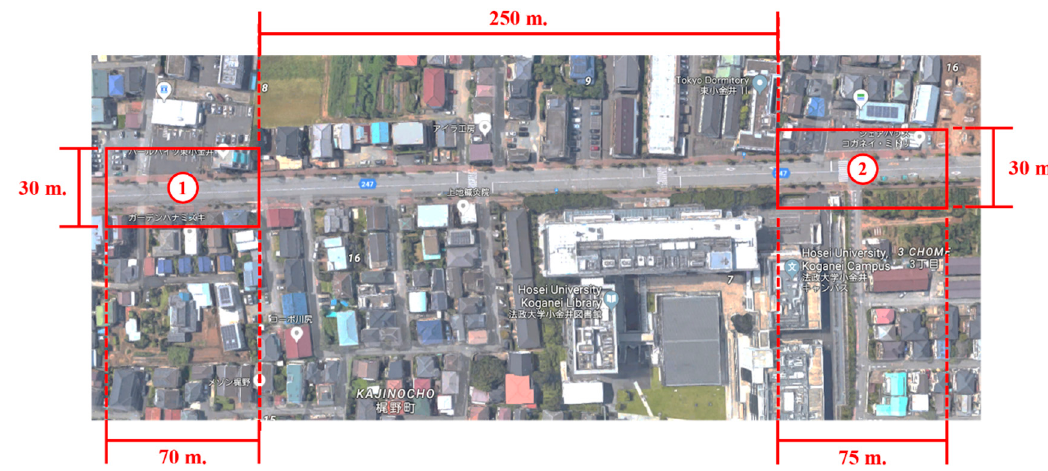
Figure 6. Map of the experimental areas (Google map). The areas of experiments are marked with the rectangles.